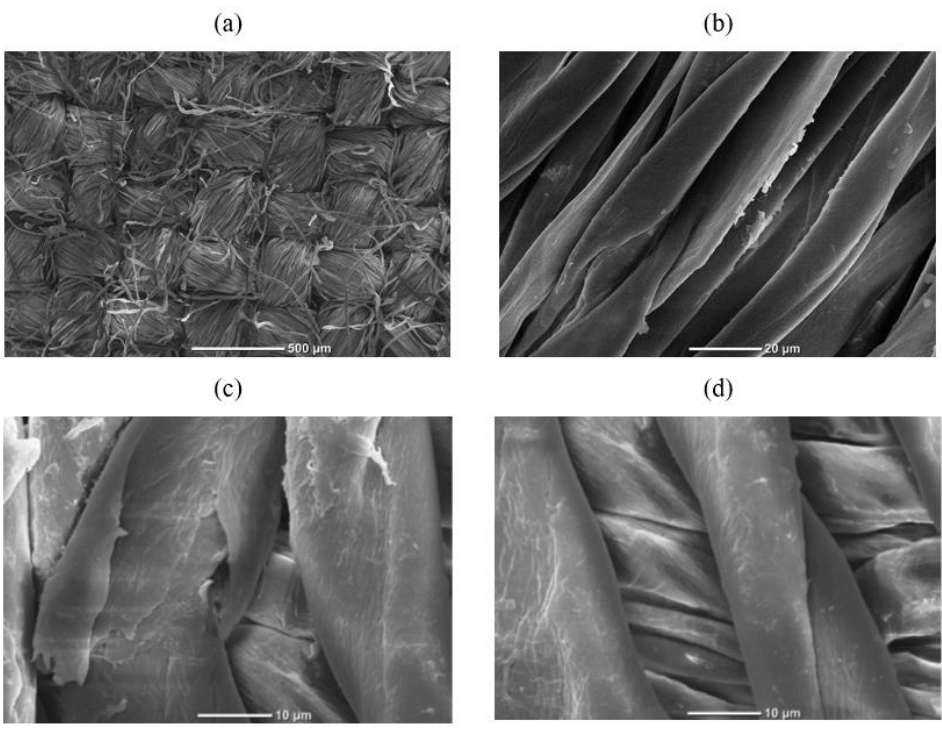
Figure 2. SEM images of ( a ) CO and ( b – d ) CO — G: Visualization of the geranium oil distribution on cotton fabrics.